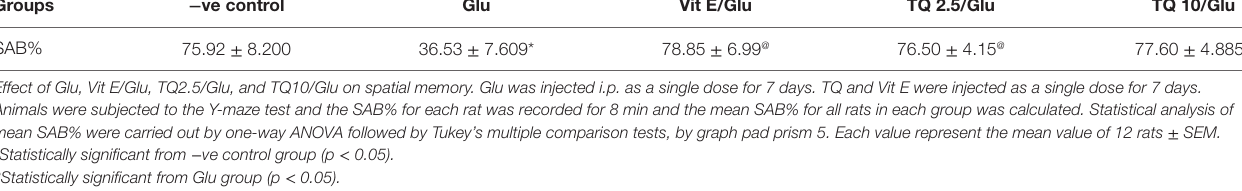
TaBle 1 | Effects of Glu, Vit E/Glu, TQ 2.5/Glu, and TQ 10/Glu on the spatial memory in the Y-maze test. groups − ve